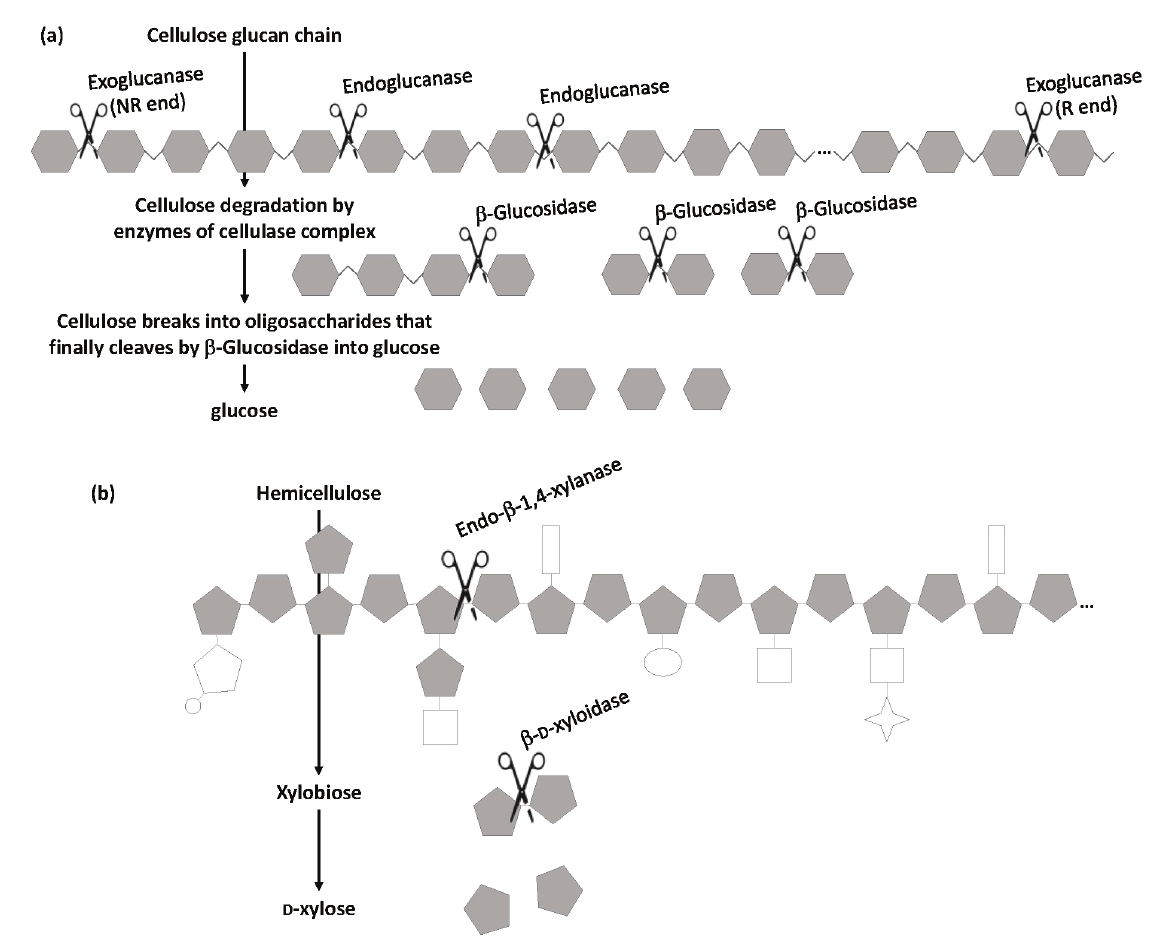
Fig. 3 – Enzymes involved in cellulose and hemicellulose